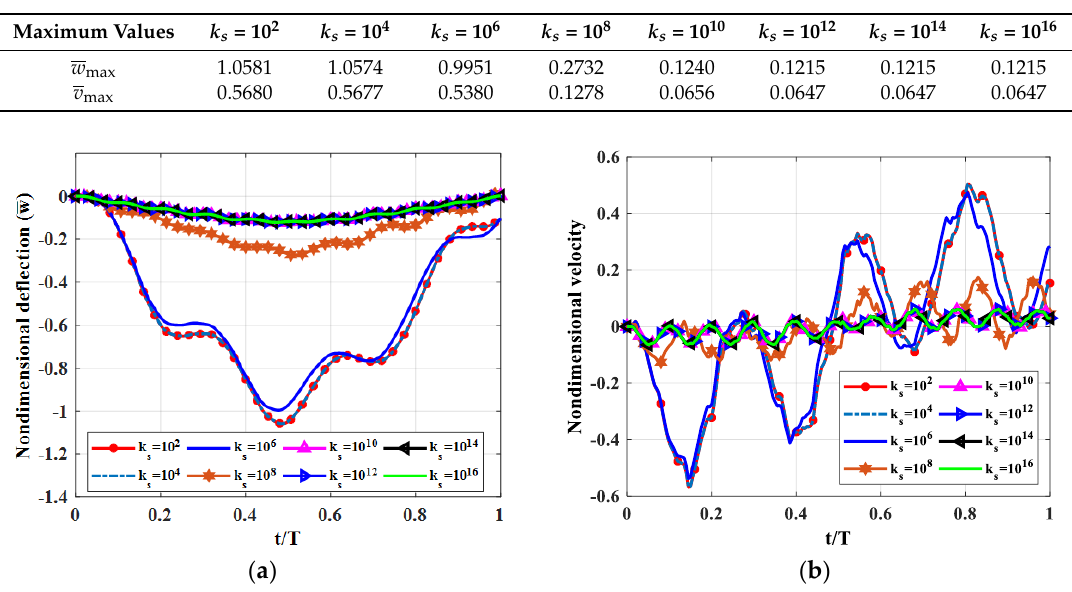
Table 3. Maximum deflections and velocities of the plate center point versus time.